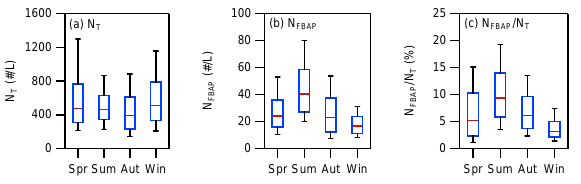
Fig. 8. Statistical representation of FBAP number concentrations and N FBAP /N T for different seasons as box-and-whisker plots. Red solid line represents median (50th percentile), lower and upper lim- its of blue box show 25th and 75th percentiles, respectively. The black error bars show 10th and 90th